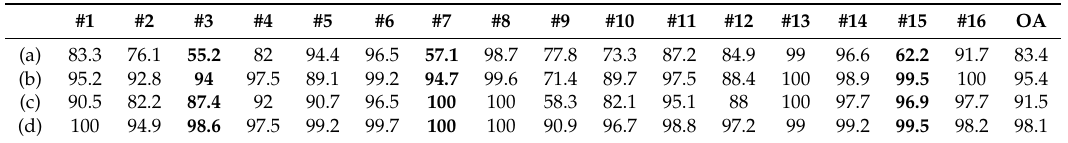
Table 4. Producer accuracy (%) on Indian Pines HSI: (a): 1D-CNN with 200 bands, (b): 1D-CNN with augmented input vectors of 641 bands, (c): 2D-CNN with input layer composed of one principal component from each pixel, (d): 1D-CNN with augmented input vectors of 1964